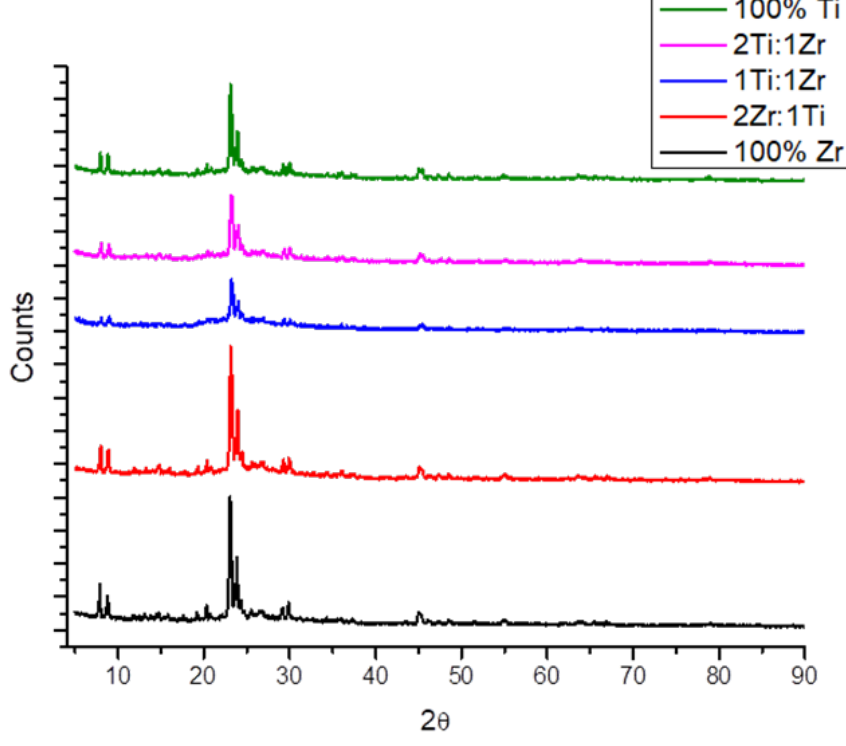
Figure 1. XRD patterns of all investigated samples.